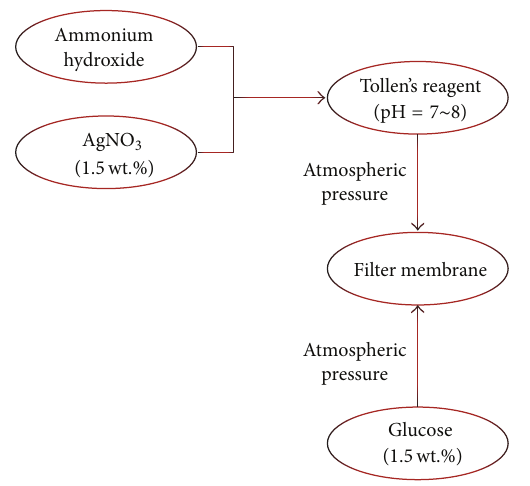
Figure 2: XRD pattern of microporous membrane decorated with silver